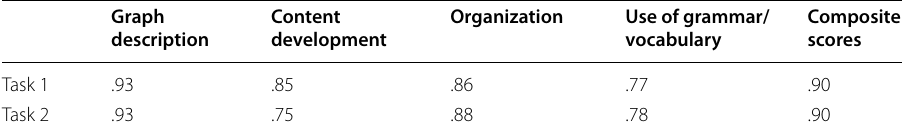
Table 2 Inter-rater reliability for the analytic and composite scores on tasks 1 and